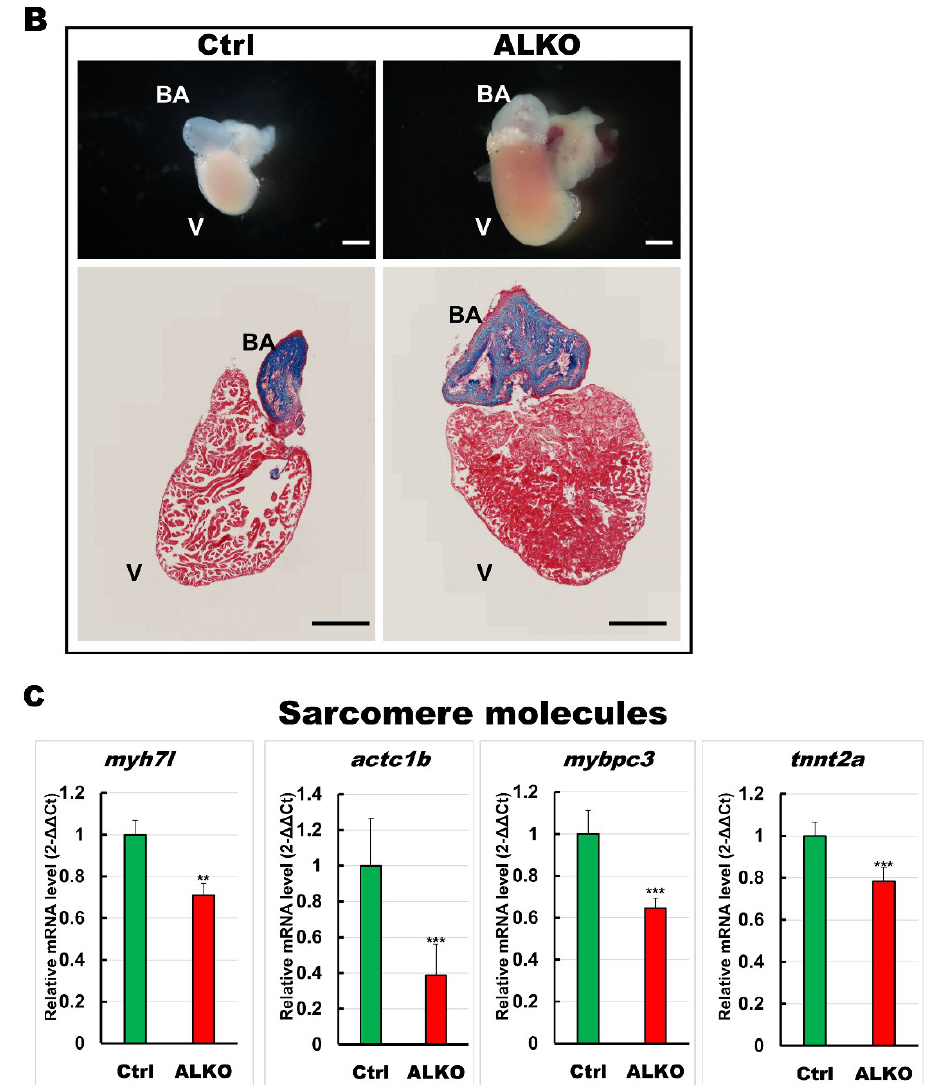
Figure 4. Hypertrophic hearts are evident in ALKO zebrafish in the larvae/adult stage. ( A ) Defective Atgl enlarged the ventricle size in ALKO at 5 dpf. Scale bar: 500 μ m. The relative ventricle area was measured by the ventricle area of the control and ALKO 5 dpf embryo. Percentage of ventricle volume area in Ctrl = 100 ± 8.0138, and ALKO = 118.6974 ± 12.1794. (Control, n = 9; ALKO, n = 11). ( B ) Upper: The later view of the hearts in control and ALKO at 5 mpf. Lower: Paraffin-embedded sections of the hearts of control and ALKO at 5 mpf with Masson trichrome stained. Scale bar: 200 μ m. B.A.: bulbus arteriosus, V: ventricle. ( C ) Molecule analysis of ALKO demonstrated the downregulation of sarcomere genes in the ventricle of 5 mpf ALKO ( n = 3). Values of myh7l = 0.7088 ± 0.0564, actc1b = 0.3882 ± 0.145, mybpc3 = 0.6449 ± 0.0474, and tnnt2a = 0.7824 ± 0.0671 in ALKO group. Statistically significant differences from the controls are indicated by ** p < 0.01, and *** p < 0.001.